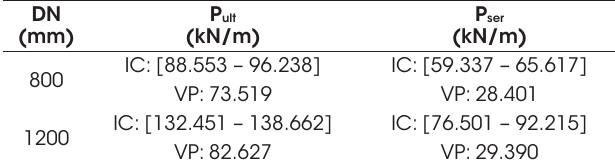
Confidence intervals (CI) for 95% of confidence and design values (DV) of P in the reinforced concrete pipes calculated with specimen mean values